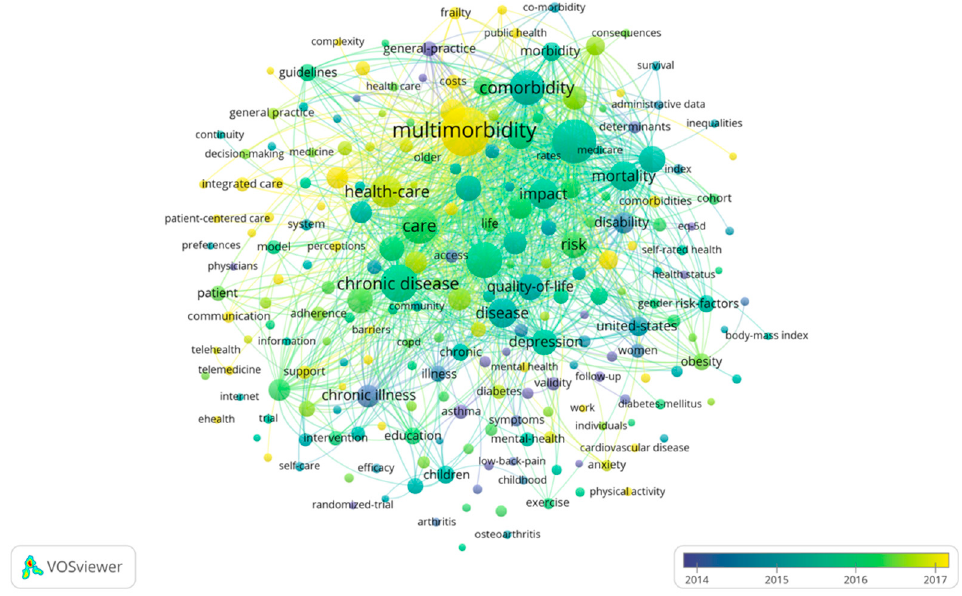
Figure 8. Burst keywords analysis of global high-frequency.